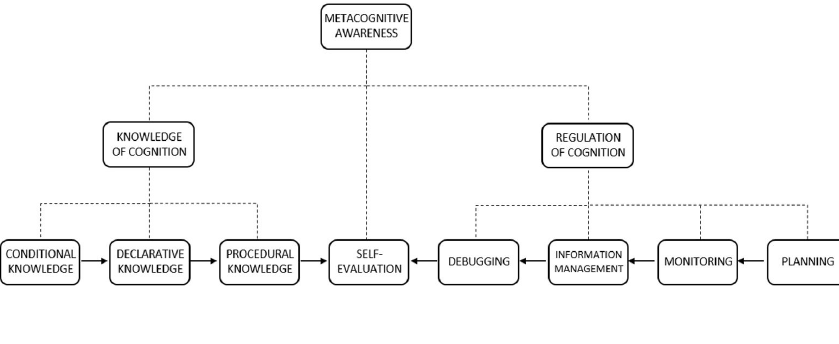
Figure 2. The components of metacognitive awareness